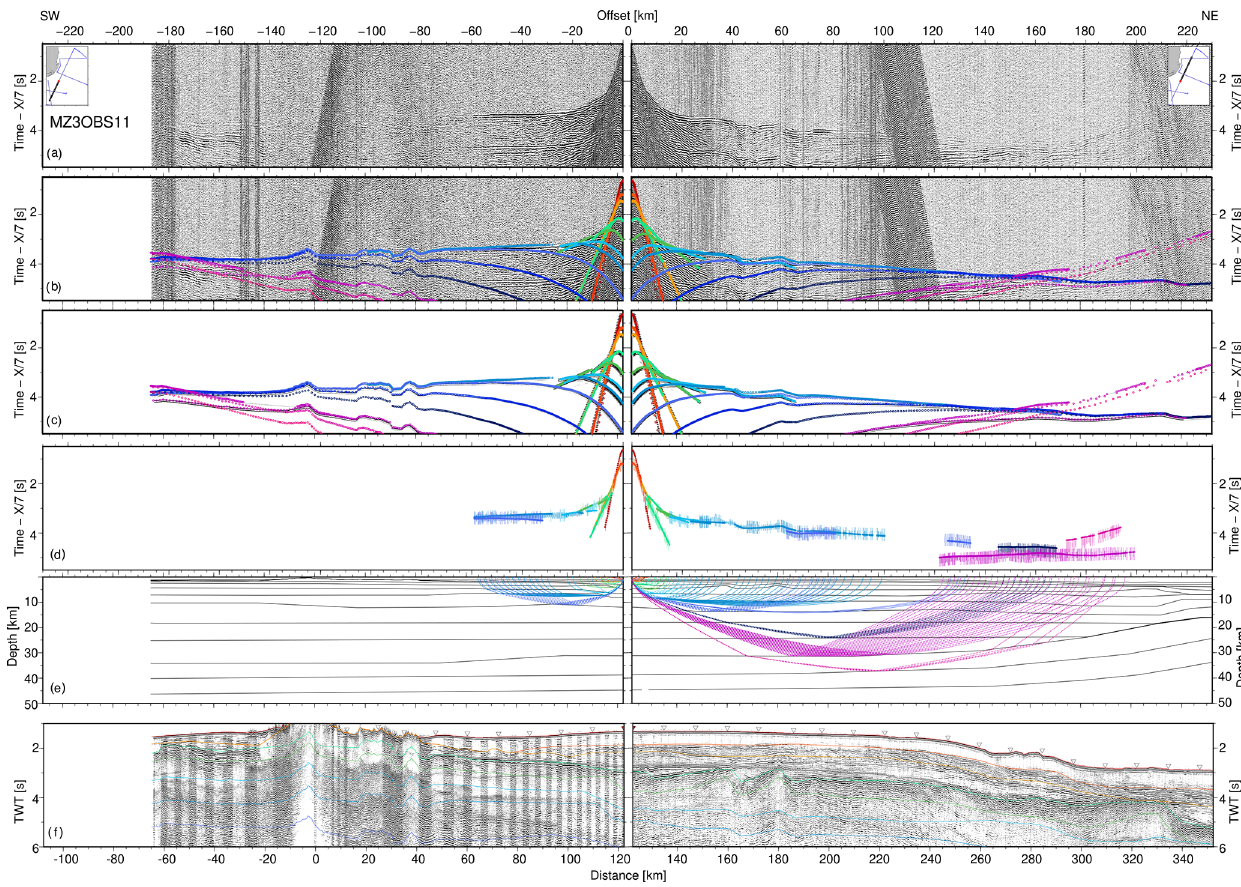
Figure 7. The same as Fig. 6 but for